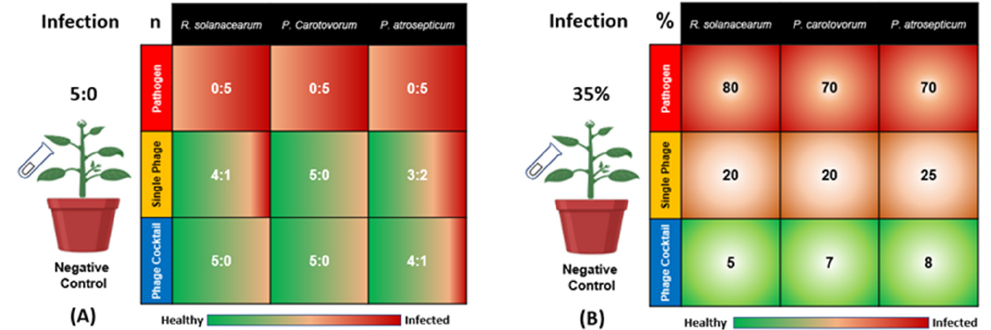
Figure 1. Effects of phage therapy on the incidence of potato bacterial disease in terms of healthy: infected plants for all treatments ( A ) and Percentage of disease symptoms after different treatments ( B ). Positive control or pathogen groups: inoculated with R. solanacearum (Rs), P. carotovorum (Pc), or P. atrosepticum (Pa), respectively; Single phage groups (SRs, SPc, and SPa): inoculated with R. solanacearum (Rs), P. carotovorum (Pc) or P. atrosepticum (Pa) and then treated with a single phage, respectively; Phage cocktail groups (RsPck, PcPck, and PaPck) : inoculated with R. solanacearum (Rs), P. carotovorum (Pc) or P. atrosepticum (Pa) and then treated with phage cocktails, respectively. “n” is representing the number of healthy: infected plants and “%” is indicating the percentage of the disease symptoms revealed on the infected plants.